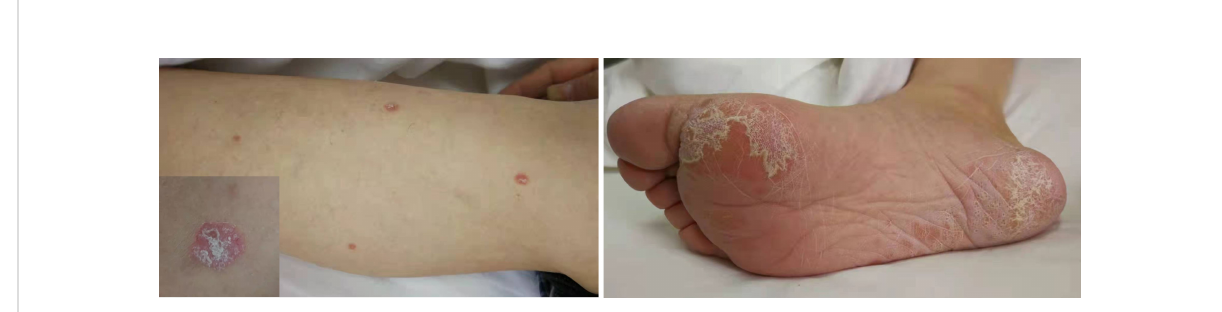
FIGURE 3 The management of nivolumab-related exfoliative dermatitis